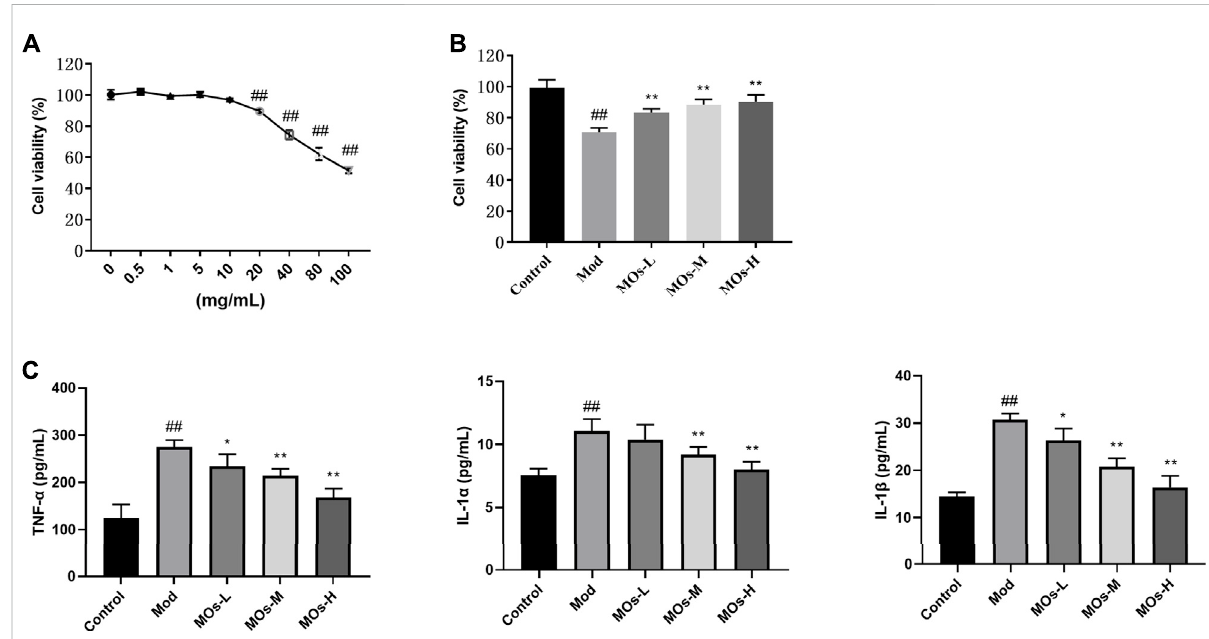
FIGURE 6 Protective effects of MOs against LPS- and ATP-induced in fl ammation in BV2 cells. (A) BV2 cells were administrated with different concentrationsofMOsfor24 h,andthecellviabilitywasdetectedusingtheMTTassay. (B) CellviabilityassayofBV2cellsafter24 hofMOstreatment followed by LPS and ATP stimulation. (C) ELISA assays to determine the production of TNF- α , IL-1 α and IL-1 β in BV2 cells. Data are expressed as means ± SD ( n = 6). ## p < 0.01 vs. control; * p < 0.05; ** p < 0.01 vs.